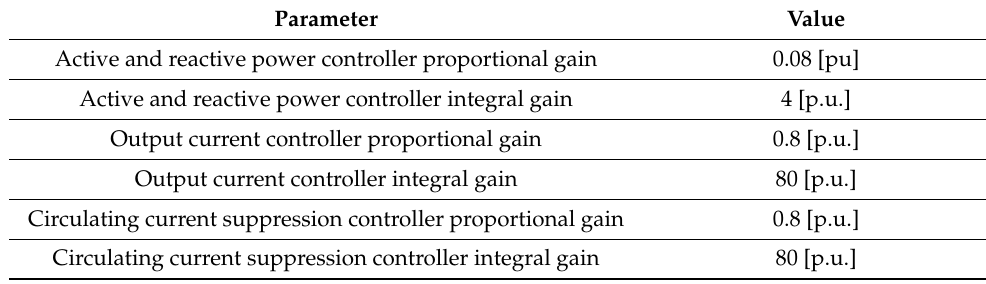
Table 2. Proportional and Integral gain parameter of the classical CCSC, OCC, and power PI controllers from Figure 4.